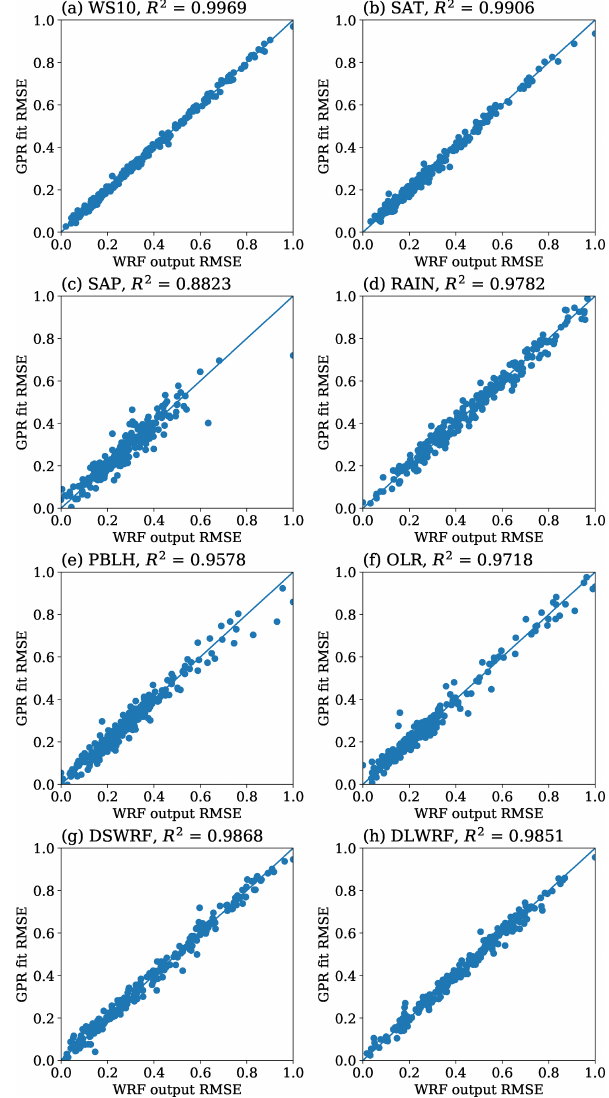
Figure 8. Accuracy of the GPR model for a sample size of 250 for the meteorological variables considered. Horizontal axis de- notes the RMSE from WRF model and the vertical axis denotes the RMSE from GPR